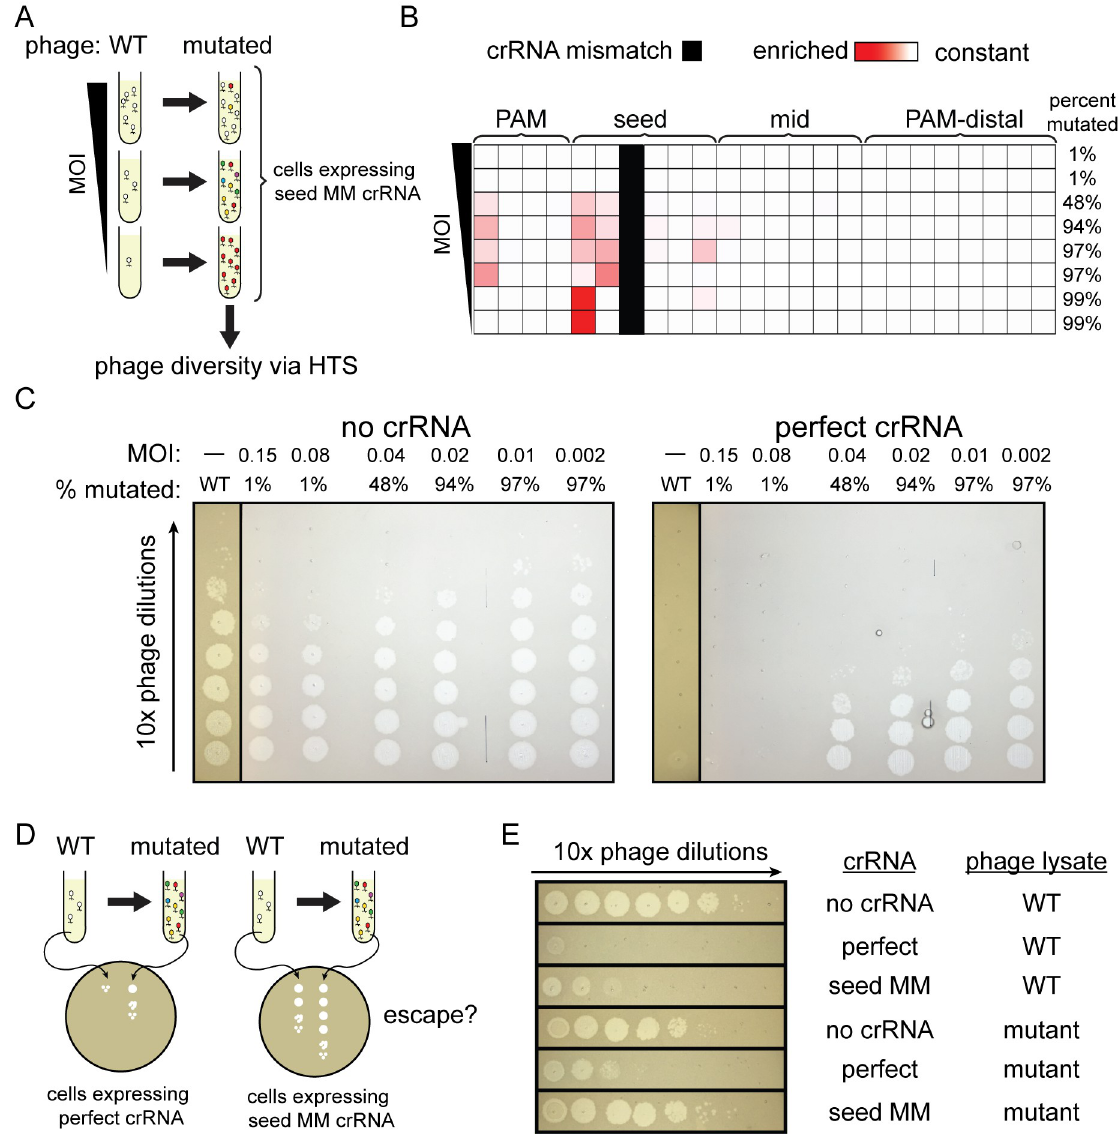
Fig 5. Combined mismatches are necessary for complete phage escape. (A) Schematic for experiment to test the impact of MOI on escape phage diversity. Cultures expressing Cas12a and the position 3 mismatched crRNA targeting gene J were infected with lambda phage at varied MOIs. Mutant phages in lysates were detected by high-throughput sequencing. (B) Heat map showing the position of phage mutations that arose when infecting bacteria expressing seed mismatch crRNA at different MOIs. Phage was harvested from liquid cultures containing bacteria expressing FnCas12a and a crRNA with a C-T mismatch at position 3. Phage was added to the culture at mid-log phase at a range of MOIs starting at 0.15 and serial 2-fold dilutions from 1/2 to 1/32 and an additional sample at an MOI of 1.5 × 10 − 3 . Phage was harvested 5 h after infection. High-throughput sequencing was used to determine the percent of phages in each that had a mutation in the target region. The heat map shows the positions in the target that were enriched with mutations. These positions are colored darker red according to their Z-score relative to the control phage population. Z-scores range from 0 (white) to 10.1 (darkest red). The position of the initial crRNA mismatch is indicated in solid black. See S8 Data for quantification of variant abundance. (C) Spot assays using phage isolated from liquid cultures as described in (A) on bacteria expressing a matching crRNA. Phage harvested in (A) was 10-fold serial diluted and spotted on bacteria with a crRNA matching the wild-type lambda phage genome target (matching crRNA) or bacteria without a crRNA guiding Cas12a (no crRNA). Wild-type phage controls were spotted on these same bacterial strains. Phages harvested from the lowest MOI cultures were omitted due to their low titer which prevented visible plaque formation on the CRISPR active E . coli strain. See S11B Fig for full plates. (D) Schematic for experiment shown in panel (E). Wild-type or mutant phage populations were used for spot assays on plates with lawns of E . coli expressing Cas12a and either the perfect or the seed mismatched crRNA to determine whether the combination of the preexisting mismatch and newly acquired target mutations are necessary for complete escape from Cas12a targeting. (E) Spot assays using mutationally diverse phage on bacteria expressing crRNAs with and without mismatches. Phage was isolated from the liquid culture